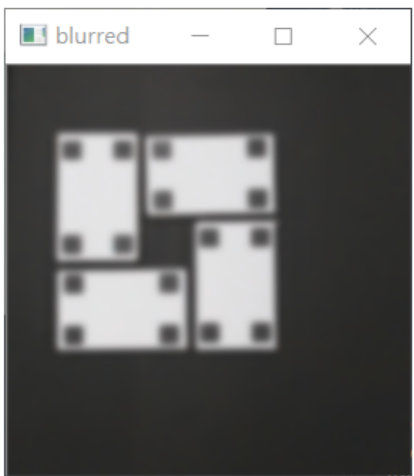
Figure 25. Gaussian blur. Figure 25. Gaussian